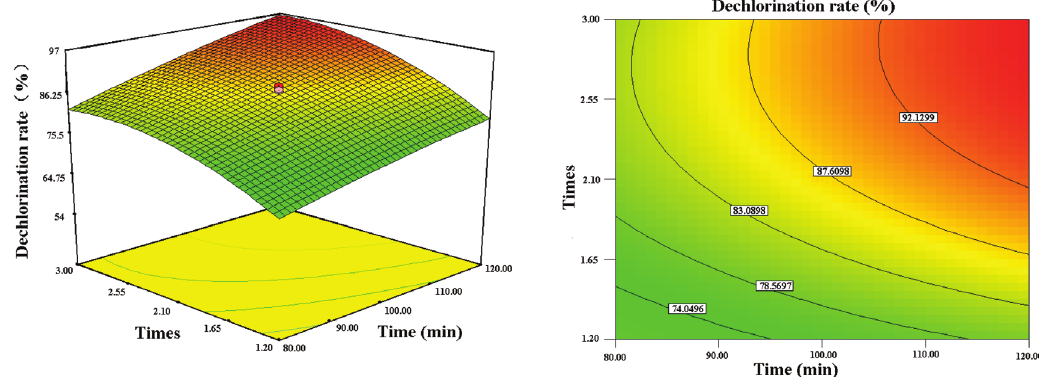
Figure 6: The interactive effects of the roasting time and oxygen consumption on the dechlorination rate by microwave roasting under oxygen-enriched